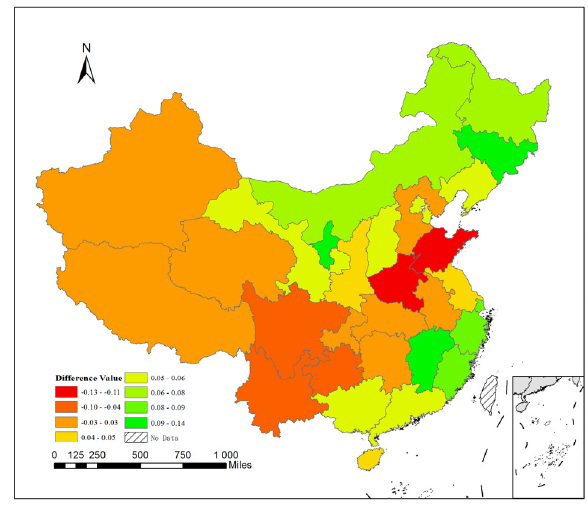
Figure 5. Spatial distribution of the difference value.